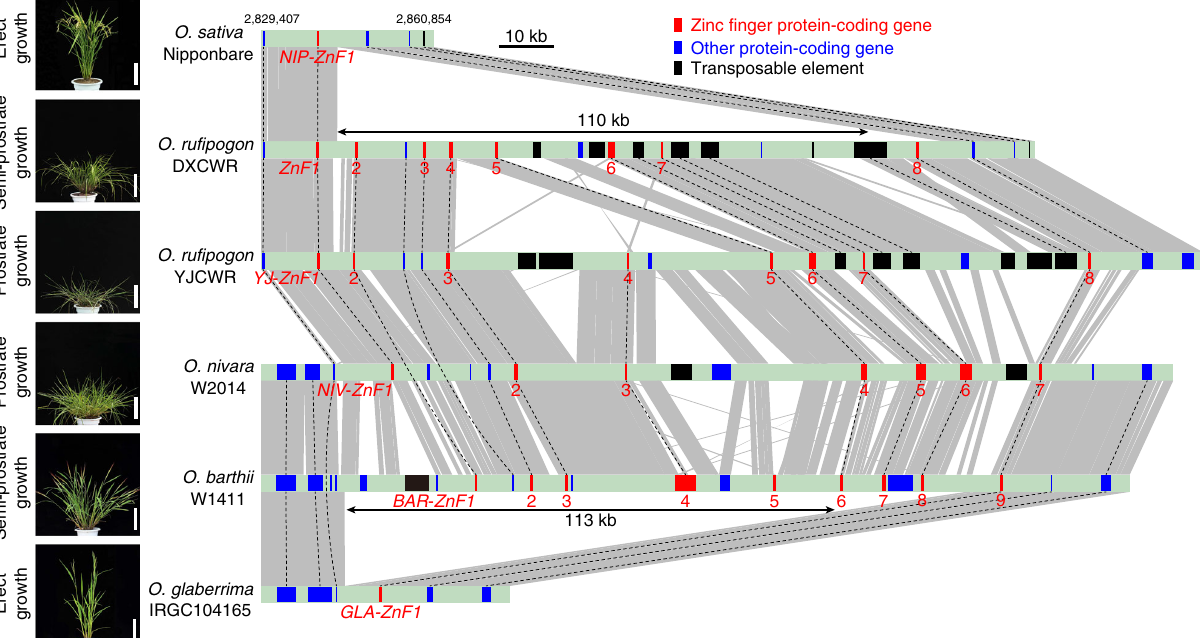
Fig. 5 Structural variations at the RPAD locus in six Oryza AA genomes. The numbers (2,829,407 and 2,860,854) showed the location of the 5 ′ and 3 ′ end in the Nipponbare reference genome (Os-Nipponbare-Reference-IRGSP-1.0, MSU7). The red, blue, and black boxes respectively indicate zinc- fi nger protein-coding genes, other protein-coding genes, and transposable elements. The gray region represents those sharing sequence collinearity. Dashed black lines indicate the orthologous relationships of genes and transposable elements. ZnF genes were named based on the 5 ′ – 3 ′ order at the RPAD locus in the corresponding accession (Supplementary Data 1 and 3). Scale bars, 20